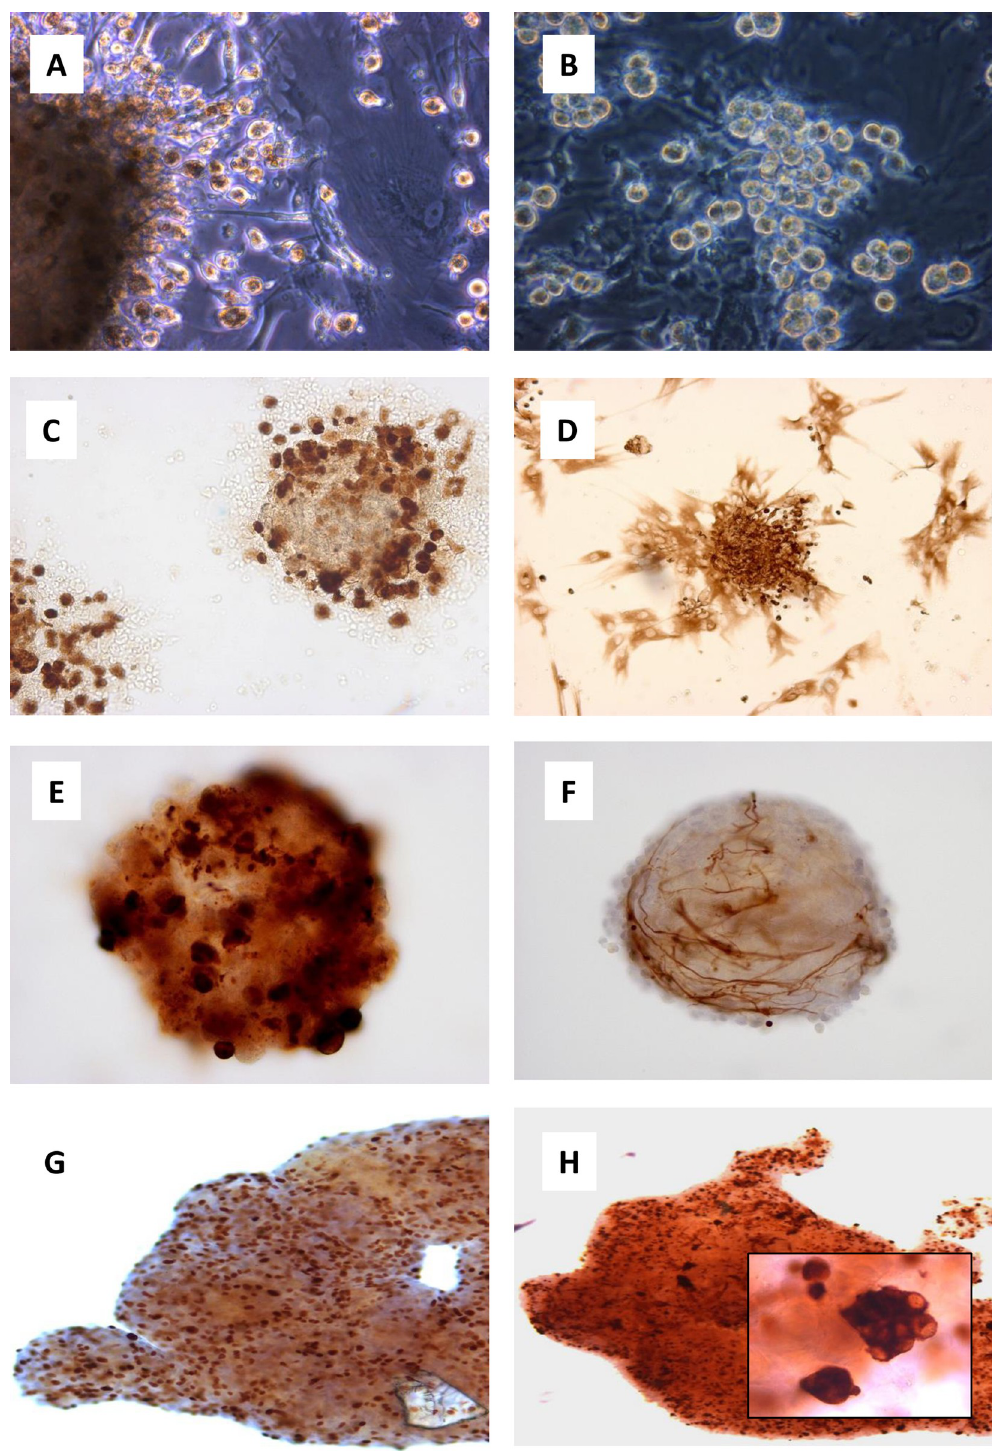
Fig 5. Large and small cell masses are a common feature of paraganglioma cultures. Cell masses appear to be anchored by fibroblast-like cells to the plastic substrate, and often ‘shed’ cells of chromaffin cell morphology during the first few weeks of culture (A, Tu42_35 days_5% FBS_20x obj. phase contrast). ‘Shed’ cells are often weakly adherent to the plastic or fibroblast underlayer and can be harvested by vigorous pipetting and re-cultured (B, Tu51_58 days _1% FBS_40x obj. phase contrast). These large cell masses consist of numerous synaptophysin-positive cells in the first weeks of culture (C, Tu44_